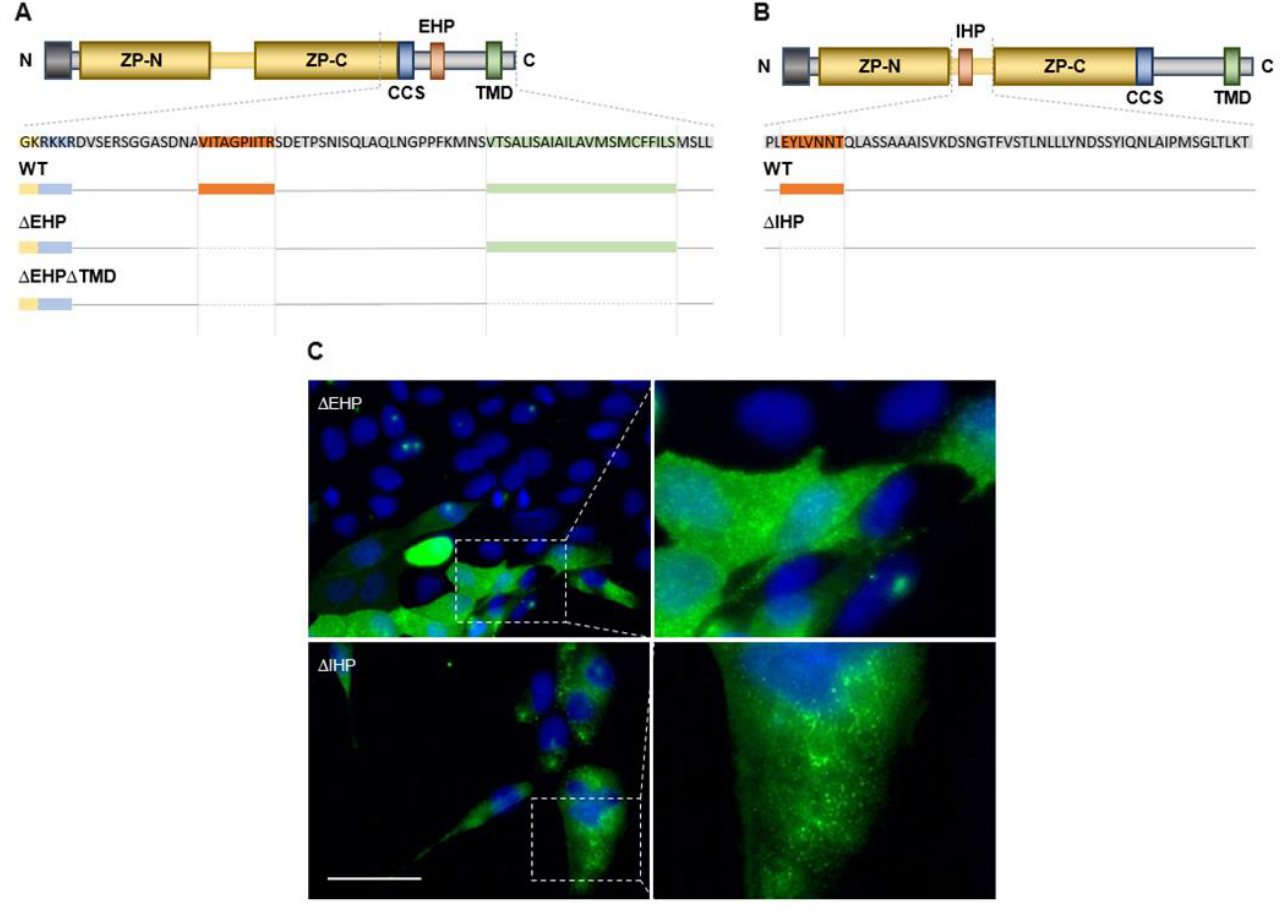
Figure 3. Polymerization defect in mutants lacking putative EHP and IHP sequences. ( A , B ) Domain structure and sequence excerpt of ZPLD1. The putative EHP and IHP motifs are highlighted in red, and they were completely deleted in the ∆ EHP and ∆ IHP variants. WT: wild type; ( C ) Immunofluo- rescence analysis showing mutant ZPLD1 on the cell surface of stably transfected MDCK cells fixed with PFA. Both variants are trafficked to the plasma membrane, but unlike wild type protein they do not polymerize properly. ∆ IHP forms abnormally short and less organized polymers while ∆ EHP does not form polymeric structures at all and seems to be stuck unprocessed in the plasma membrane. Scale bar, 50 µ